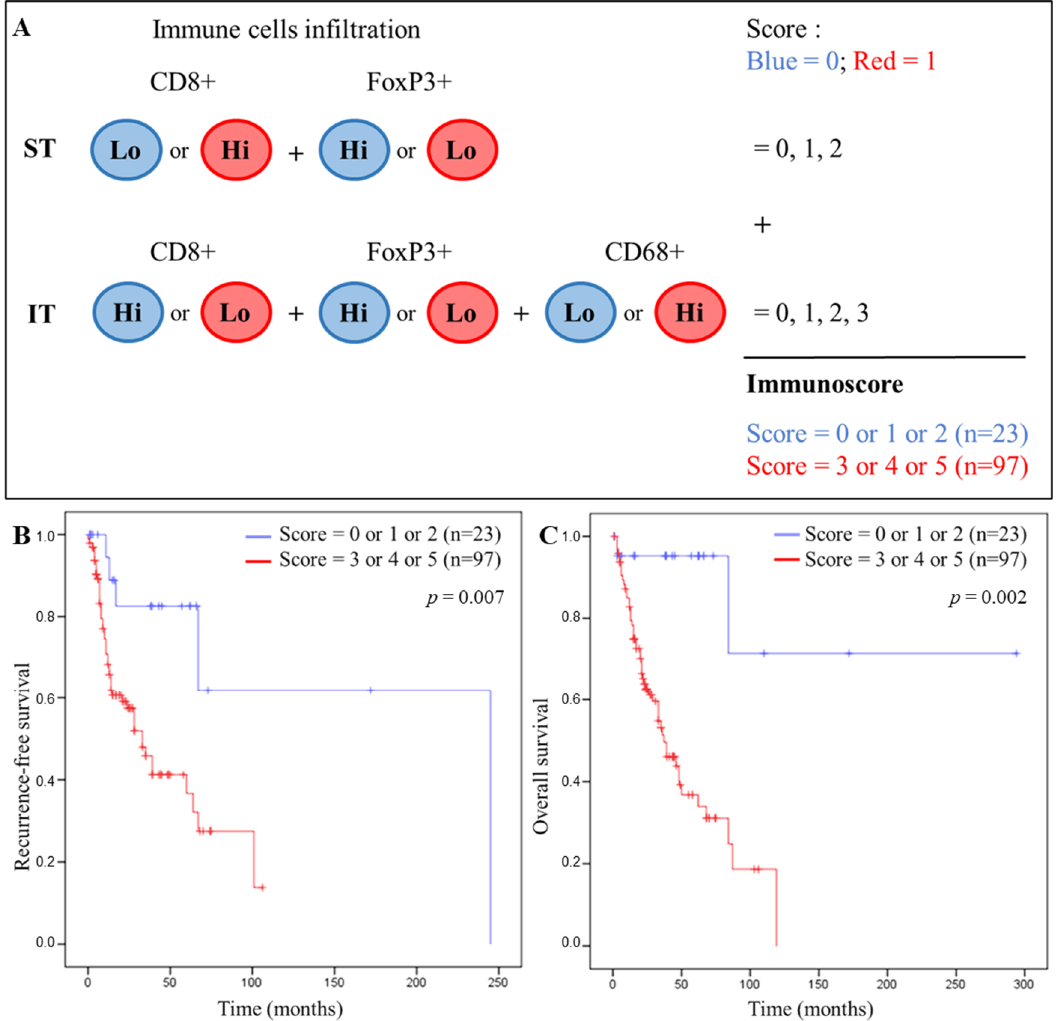
Figure 5. IS and patient survival. ( A ) Establishment of the IS in HNSCC tissues based on the immune cells infiltration in the ST and IT compartment. Each tumor is categorized into low (Lo) or high (Hi) density for each immune cell in each tumor region according to the calculated cutoff values. Depending on the immune cells and the tumor compartment, the Lo and Hi classes are associated to the blue or red group that correspond to 0 or 1 score, respectively. According to the total number of the score, each patient is classified in the blue group (low IS) or the red group (high IS). ( B ) Kaplan–Meier curves comparing recurrence-free survival (RFS) and IS and ( C ) overall survival (OS) and IS. Very significant differences were observed between the blue and red IS. Kaplan– Meier curves using our IS showed a significant correlation for RFS ( p = 0.007) and OS ( p =